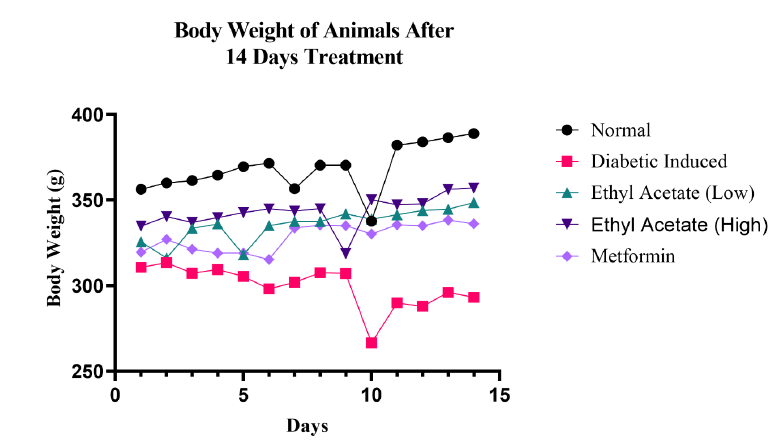
Figure 1. Changes in body weight in diabetic induced rat after 14 days of cultivated C. racemosa EtOAc extract treatment.